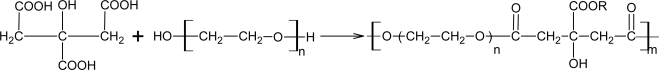
Reaction formula of condensing PEG and citric acid [142].